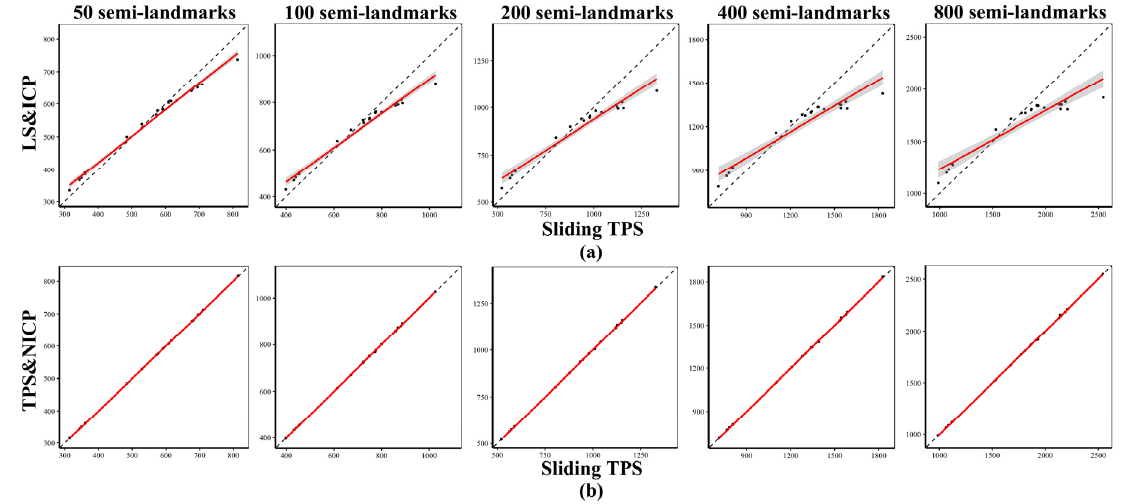
Figure 4. Comparisons of centroid sizes estimated by different semilandmarking approaches. ( a ) Sliding TPS vs. LS&ICP. ( b ) Sliding TPS vs. TPS&NICP.